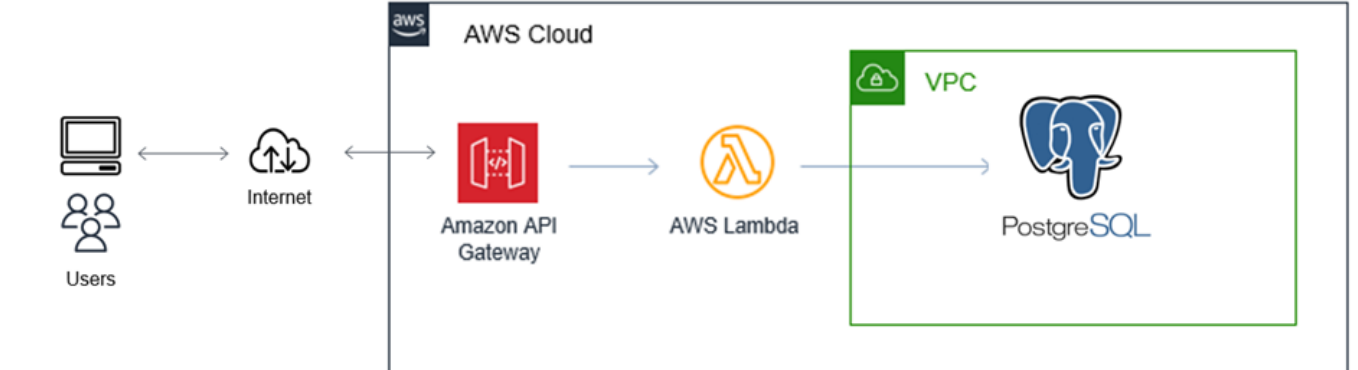
Figure 2. BRIDE serverless architecture.